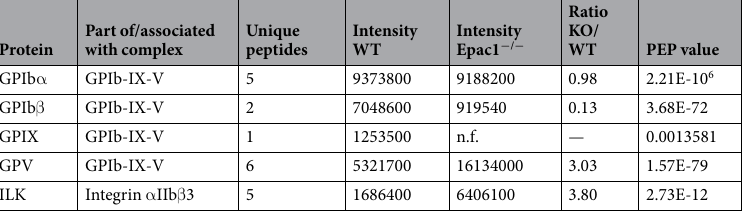
Table 2. The impact of Epac1 deletion on expression of ILK and GPIb-related platelet adhesion proteins, detected by proteomics. ILK, integrin linked protein kinase, GP, glycoprotein.